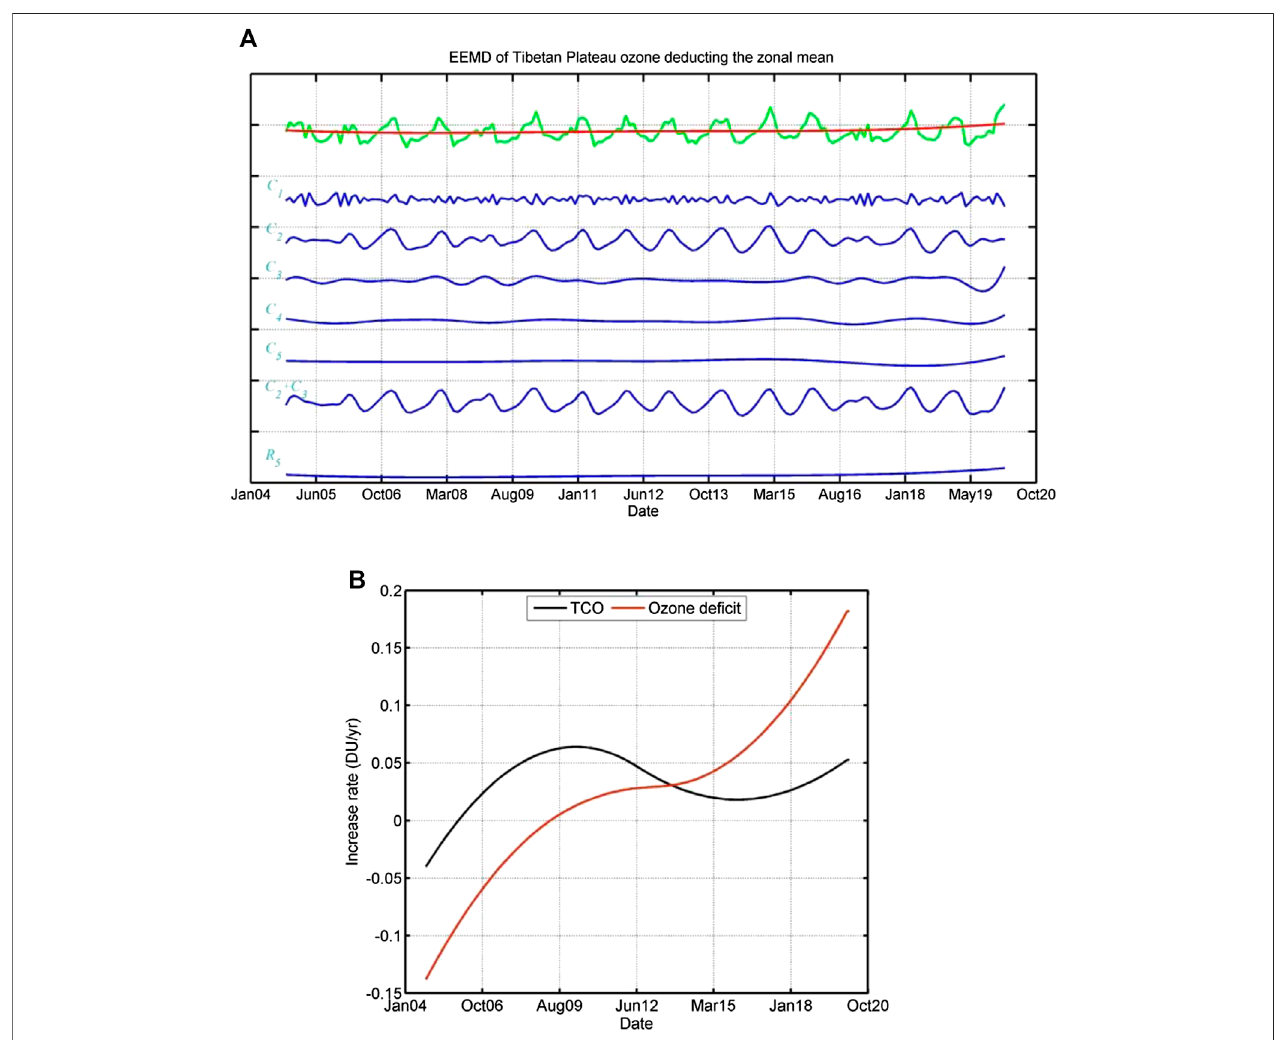
FIGURE6| EEMDdecompositionsofozonede fi citovertheTP (A) andthemonthlyincreaseratederivedfromR5 (B) .Forcomparison, theincreaseratefromTCO over the TP is also shown in the lower panel (B) .